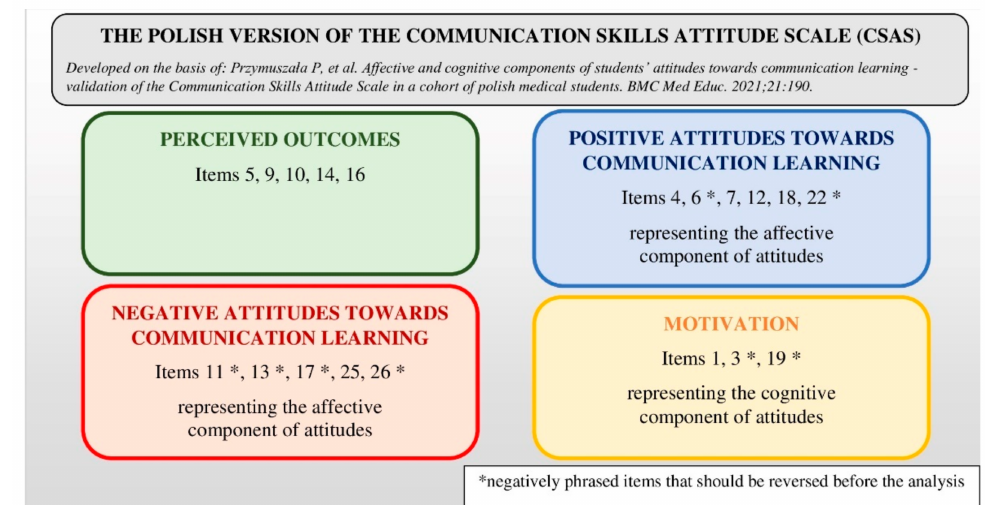
Figure 1. Visualization of the Polish version of the Communication Skills Attitude